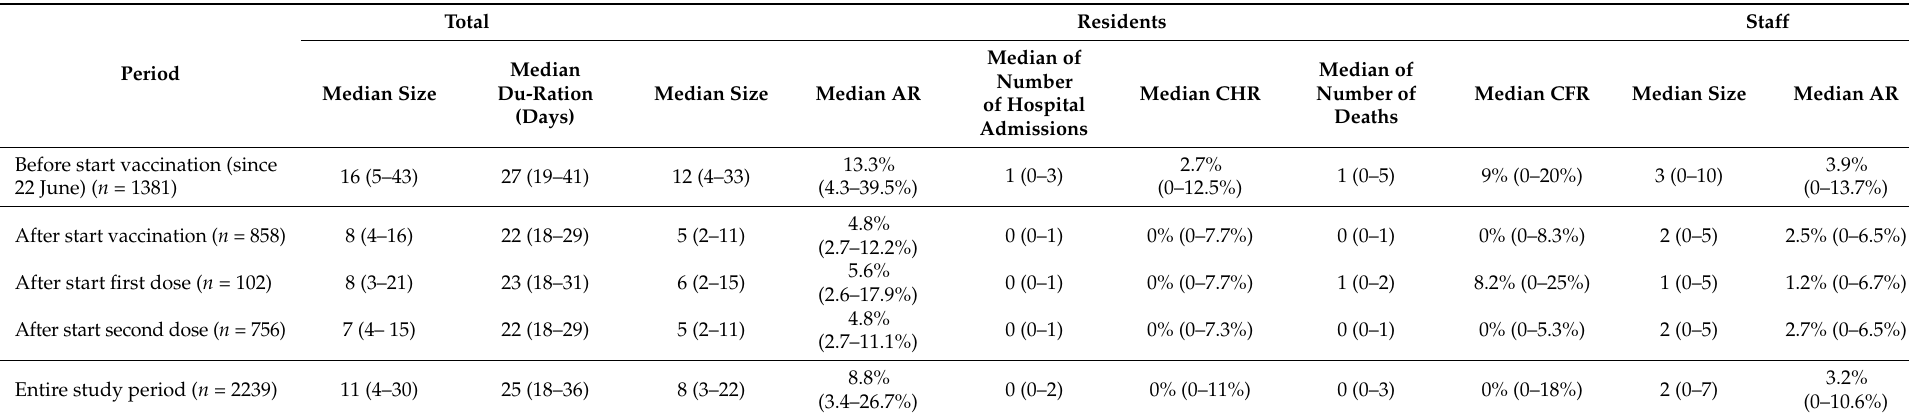
Table 3. Cluster characteristics (size (number of COVID-19 confirmed cases), duration (days)), number of hospital admissions and deaths, per population (total, residents, and staff) and vaccination period expressed as median and interquartile range, recorded in Belgian nursing homes between 22 June 2020 and 2 January